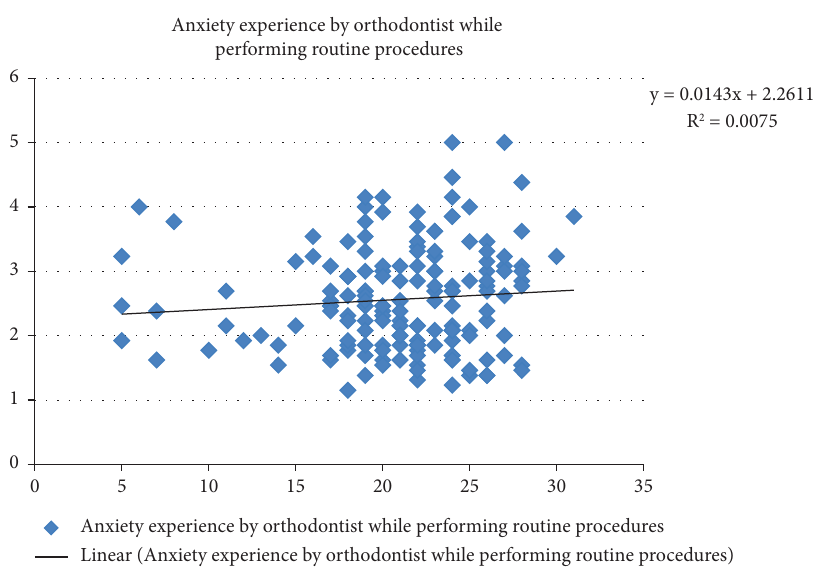
Figure 7: Association of COVID-19 related knowledge scores and anxiety experienced by orthodontic residents while performing routine orthodontic